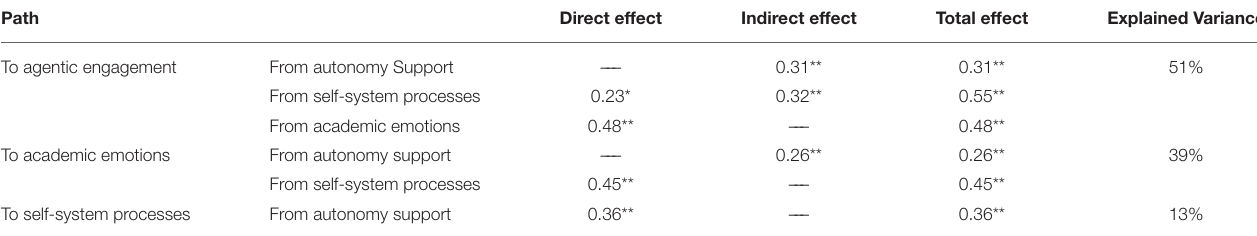
TABLE 3 | Direct, indirect and total effects in